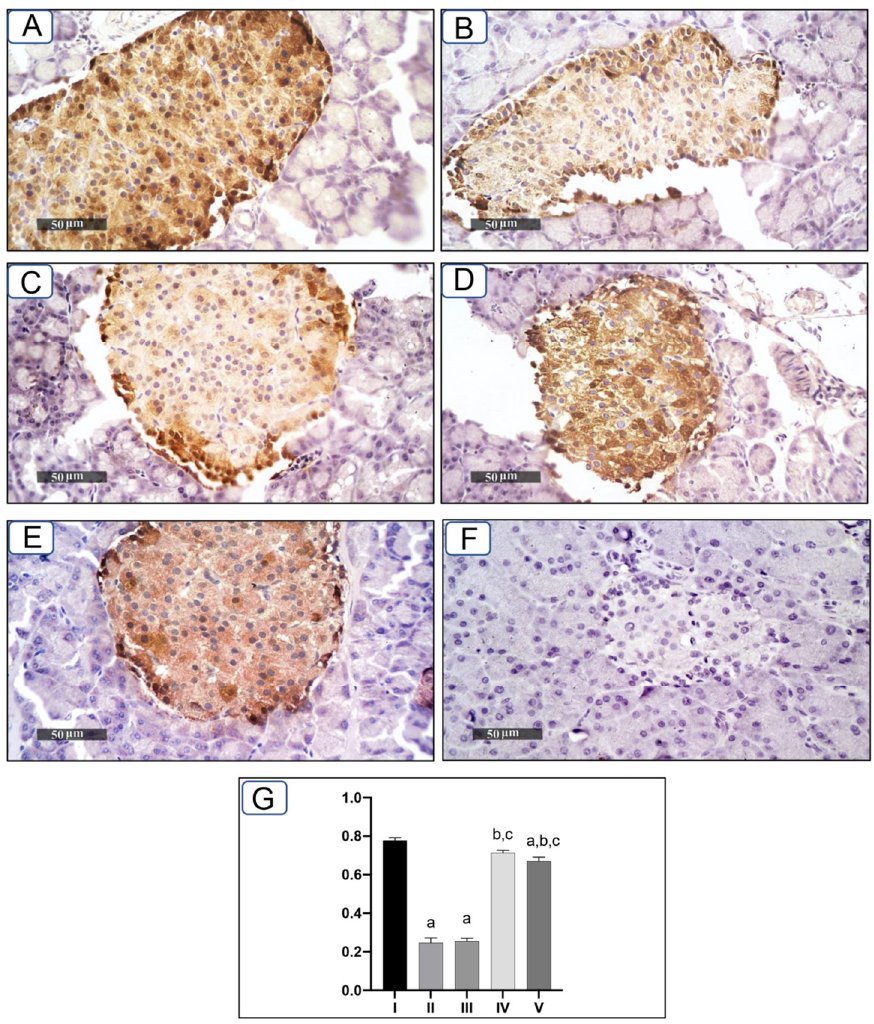
Figure 2. Immunohistochemical expression of insulin in pancreatic tissues in different groups. Group I (control) ( A ), group II (diabetic) ( B ), group III (50 mg/kg, cichoriin) ( C ), group IV (100 mg/kg, cichoriin) ( D ), group V (5 mg/kg, GB) ( E ), negative control ( F ), and semi-quantitative analysis of immunoreactivity of anti-insulin antibody in stained pancreatic sections of different groups ( G ). Data are represented as mean optical density ± SE. a , b , and c indicate significant difference from group I, group II, and group III, respectively, at ( p ≤